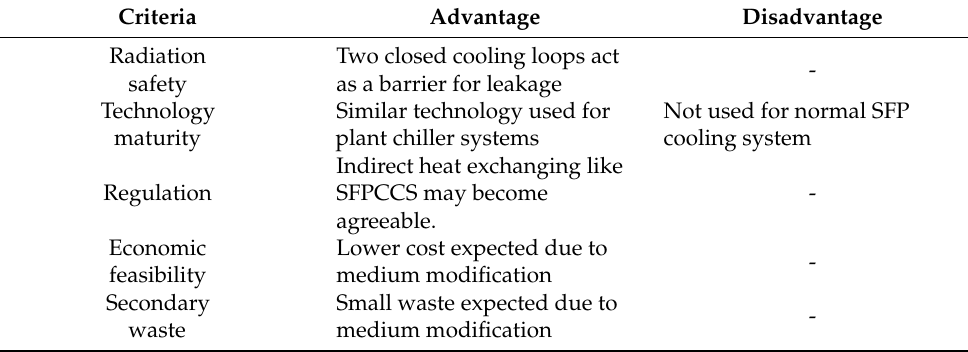
Table 14. Evaluation summary of ocean-cooled indirect heat exchange